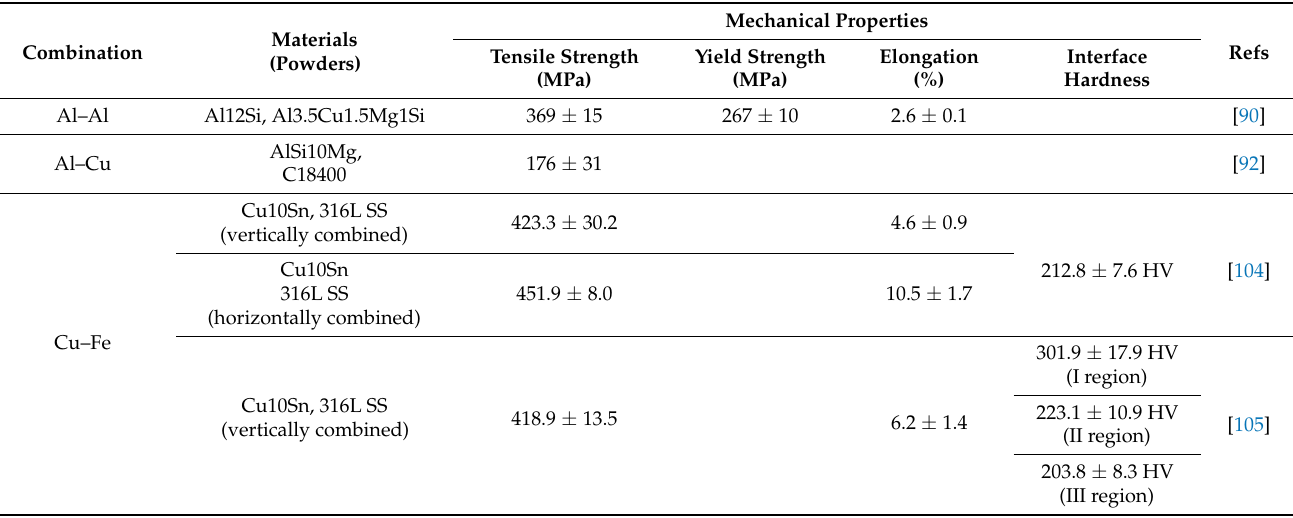
Table 1. Summary of mechanical properties of LPBF-processed dissimilar metal